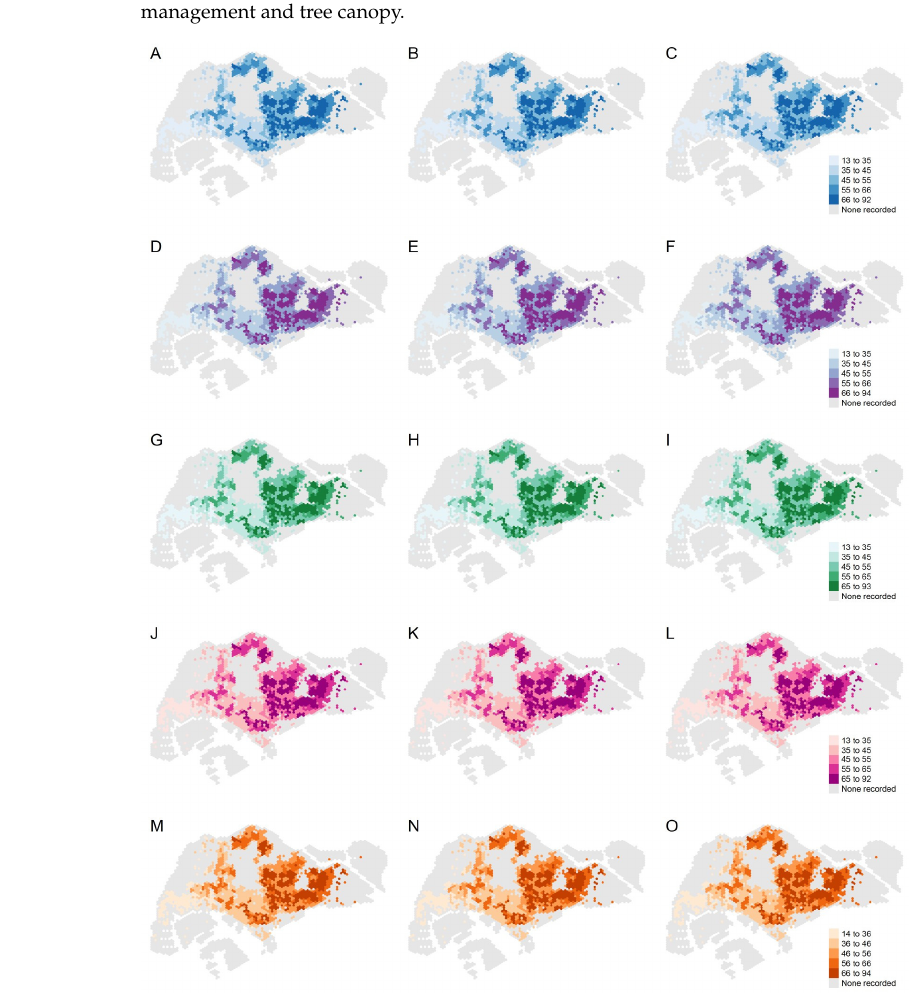
Figure 3. Top row from left to right: 30-year return levels under M1 with a ( A ) 1 percent, ( B ) 5 percent, and ( C ) 10 percent increase in freshwater surfaces. Second row from left to right: 30-year return levels under M1 with a ( D ) 1 percent, ( E ) 5 percent, and ( F ) 10 percent increase in impervious surfaces. Third row from left to right: 30-year return levels under M1 with a ( G ) 1 percent, ( H ) 5 percent, and ( I ) 10 percent increase in vegetation with human management with tree canopy. Fourth row from left to right: 30-year return levels under M1 with a ( J ) 1 percent, ( K ) 5 percent, and ( L ) 10 percent increase in the population. Fifth row from left to right: 30-year return levels under M1 with a ( M ) 1-year, ( N ) 2-year, and ( O ) 3-year increase in the median age of public apartments. The legend for the return level of each row is shown on the